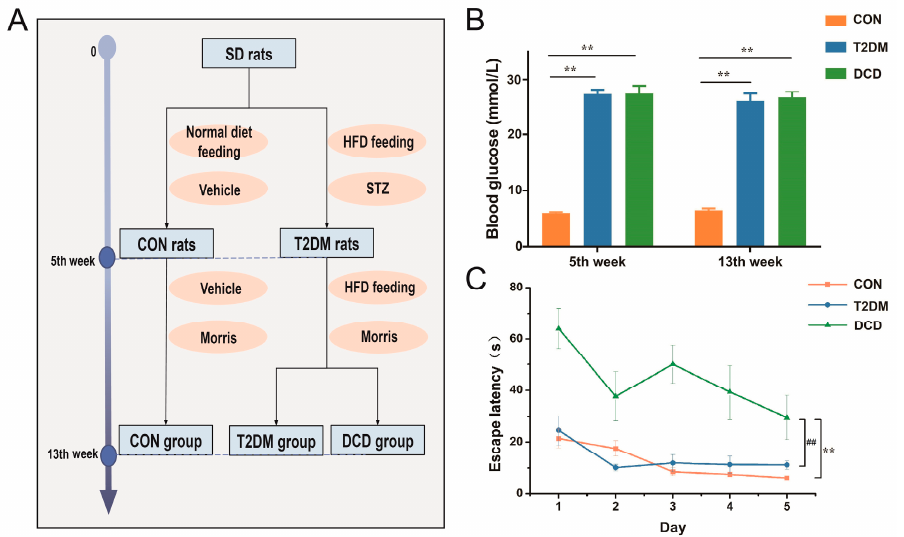
Figure 2. ( A ) Flow diagram of animal grouping and basic and behavior characteristics of the CON, T2DM, and DCD groups. ( B ) Random blood glucose levels; ( C ) average latency of the rats in the Morris water maze. (CON = control, T2DM = type 2 diabetes mellitus, DCD = diabetic cognitive dysfunction, ** p < 0.01, compared with CON group, ## p < 0.01 compared with T2DM group).